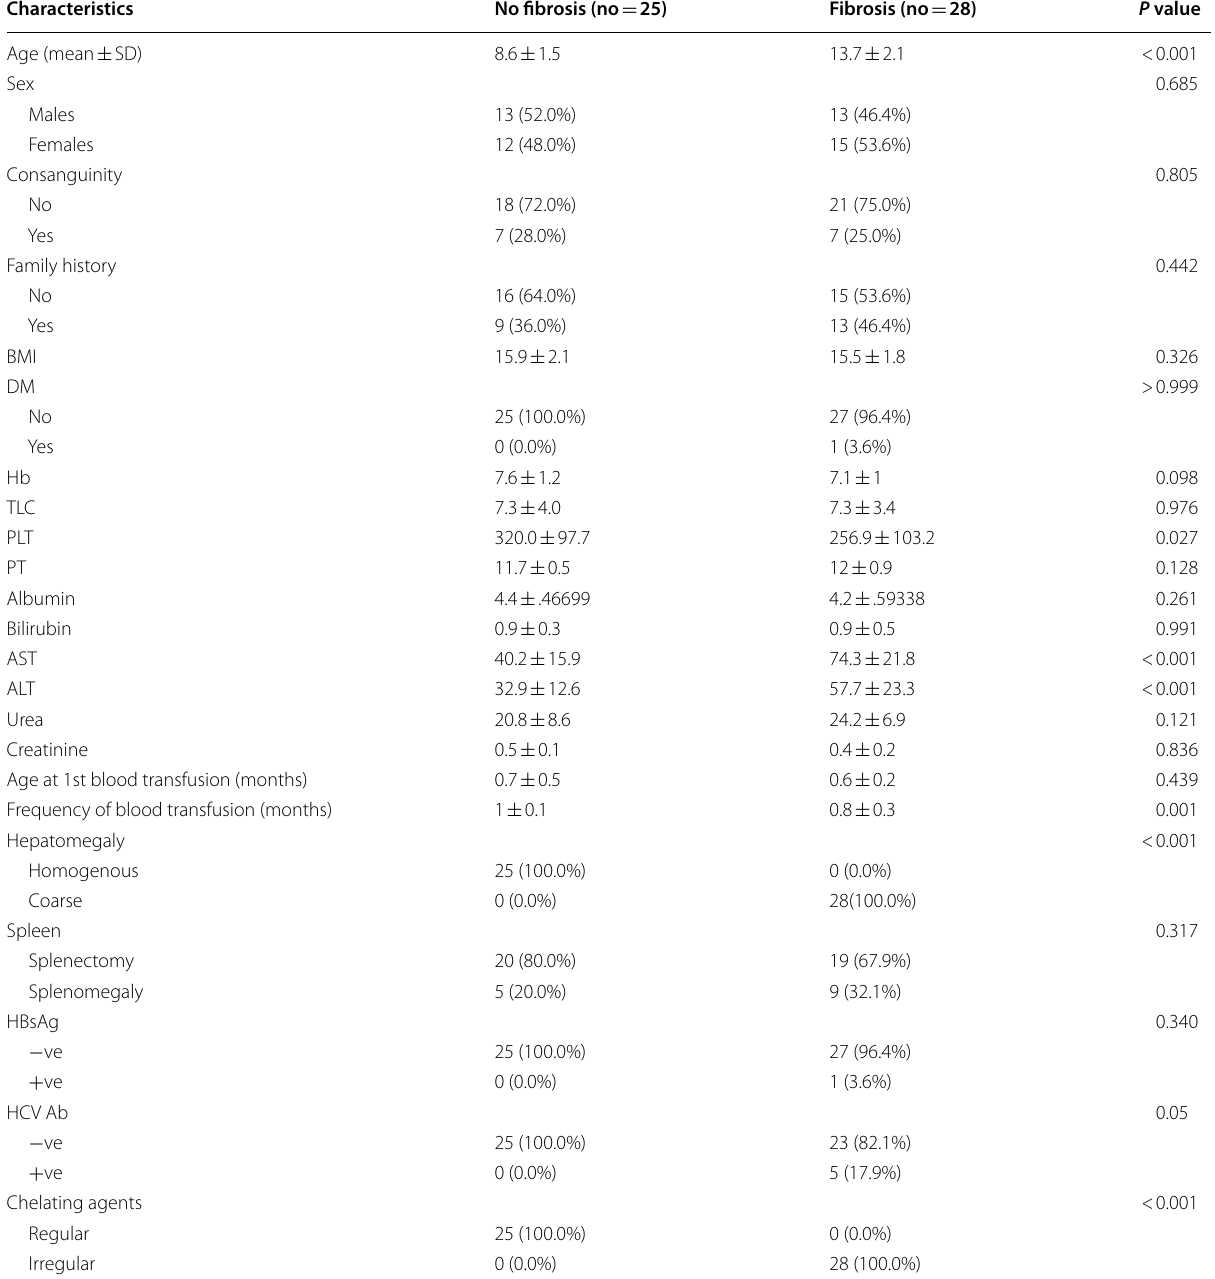
Table 3 Comparison between patients with fibrosis and patients without fibrosis regarding patients’ characteristics